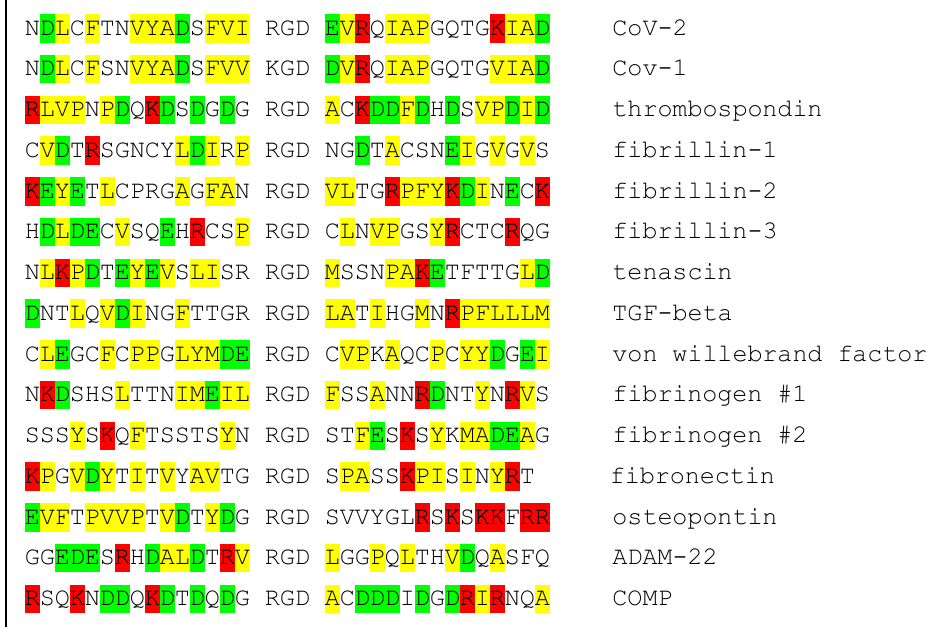
Table 1. Alignment of sequences in the neighborhoods of RGD motifs of CoV-1 and CoV-2 spike proteins and 12 known integrin ligands. Positively charged amino acids in red; negatively charged in green; hydrophobic in yellow.